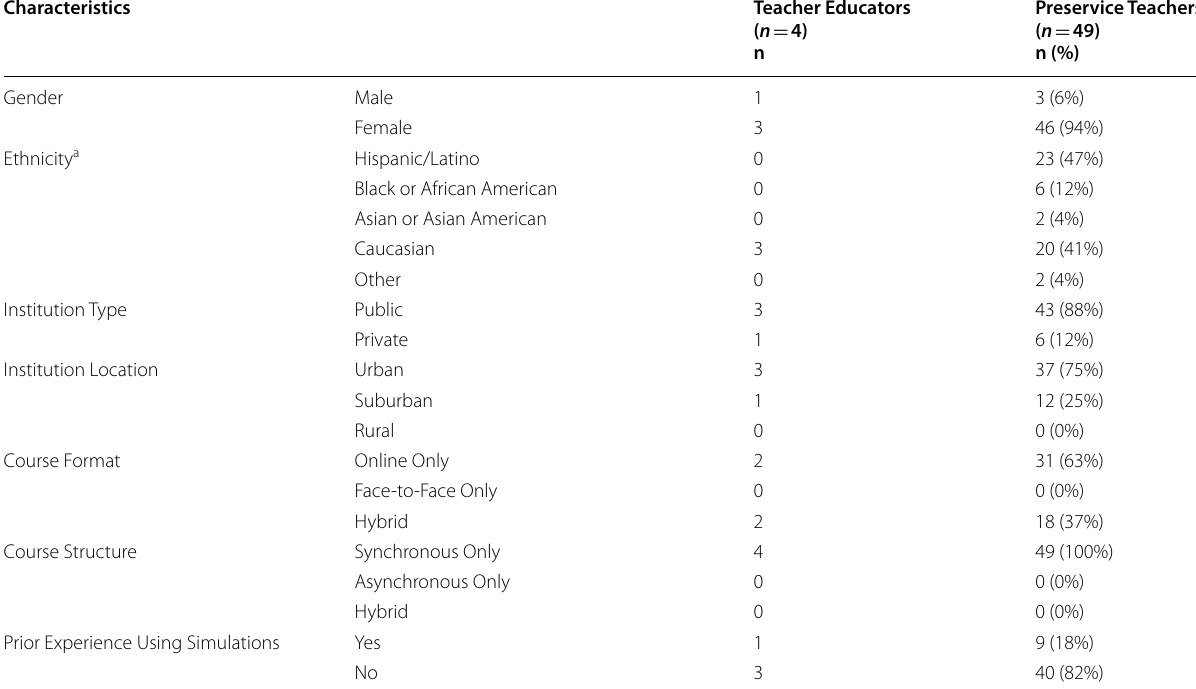
ªOne teacher educator did not respond to this question. Totals do not add to 100% because each participant could make one or more selections for ethnicity